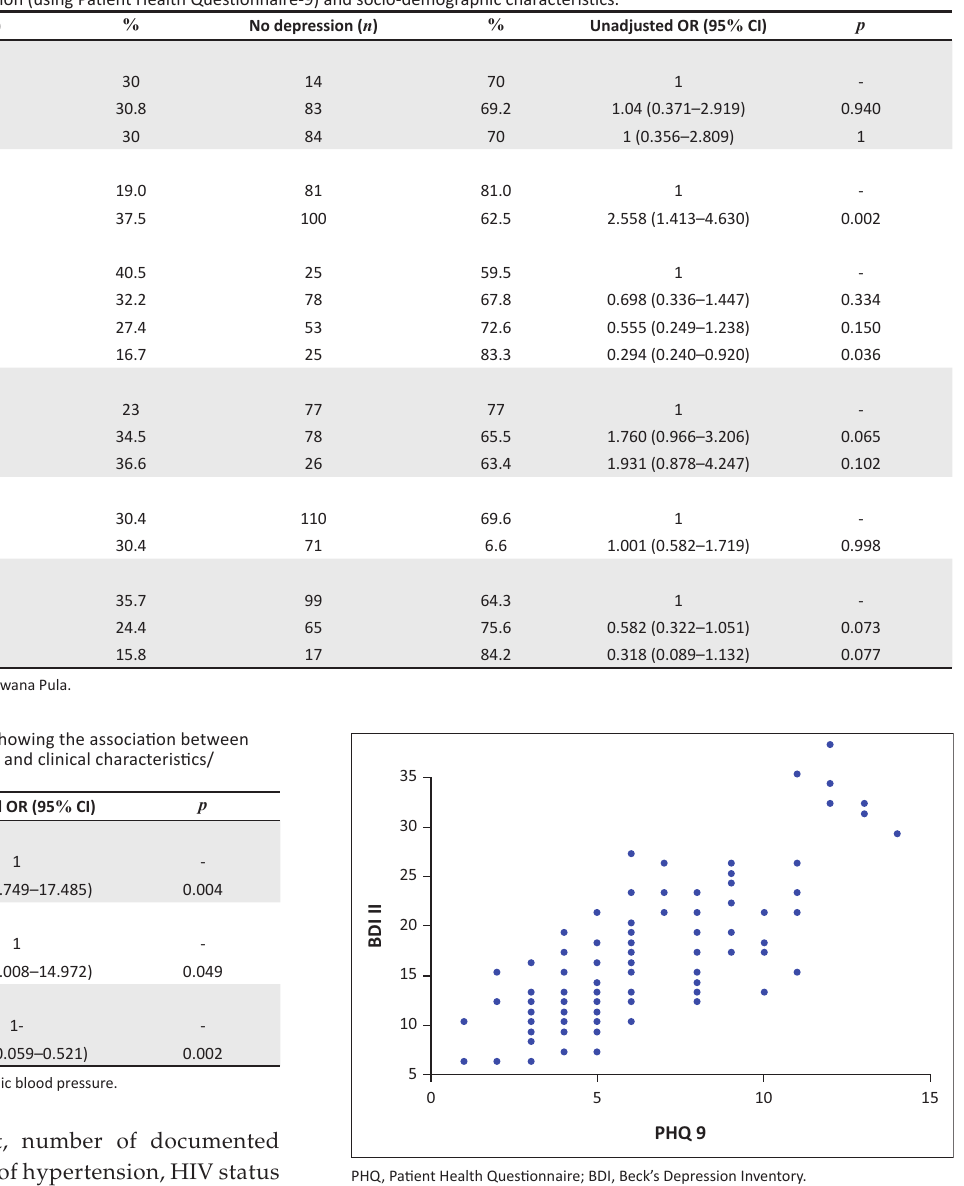
FIGURE 1: Scatter plot of Beck’s Depression Inventory II against Patient Health